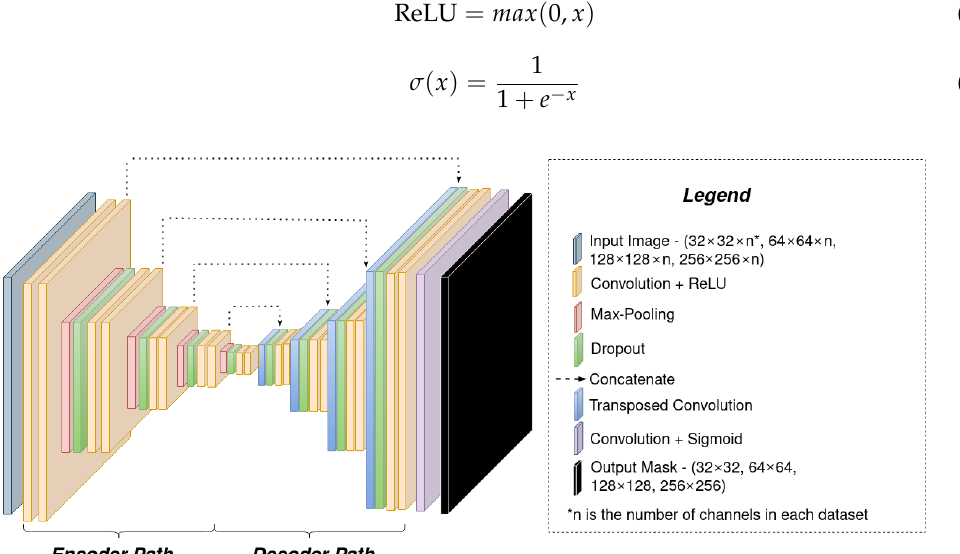
Figure 4. U-Net network